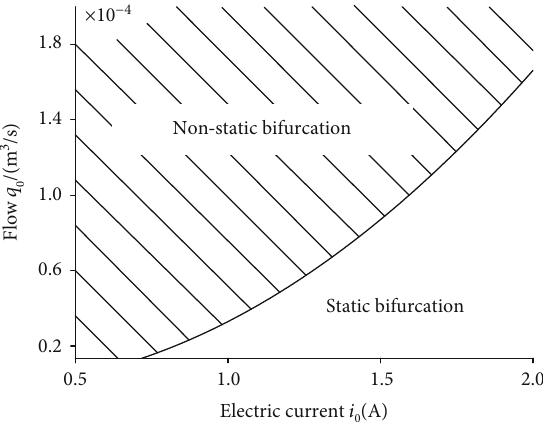
Figure 7: Bifurcation area diagram of electric current and fl